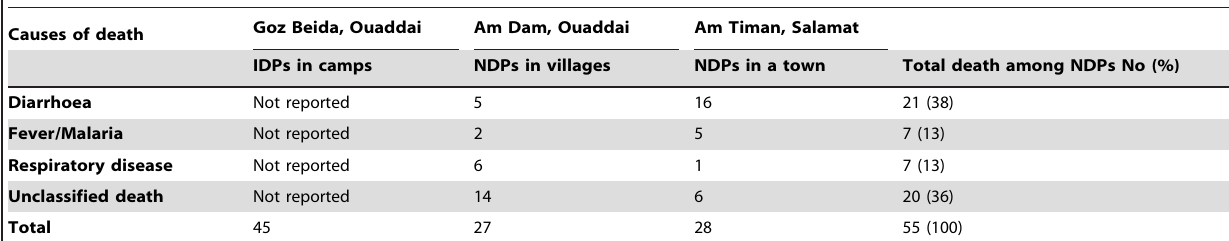
Table 2. Causes of death among the surveyed population.